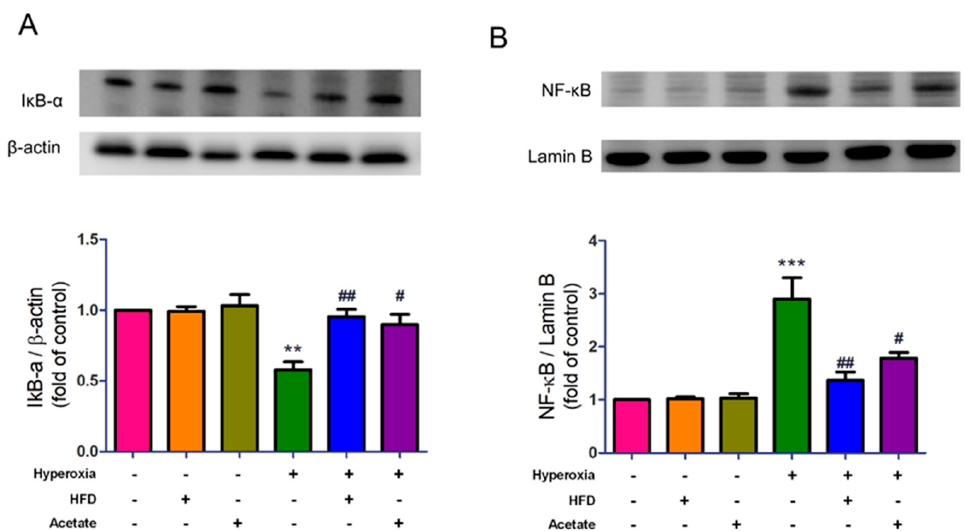
Figure 6. A high-fiber diet (HFD) and acetate supplementation suppress activation of the NF- κ B signaling pathway in mice exposed to hyperoxia. ( A ) Western blotting of cytoplasmic I κ B- α and ( B ) nuclear NF- κ B p65 (top: representative results; bottom: quantitation of data). Data are mean ± SD (three mice per group). ** p < 0.01, *** p < 0.001, compared with the ambient air group; # p < 0.05, ## p < 0.01 compared with the hyperoxia group.